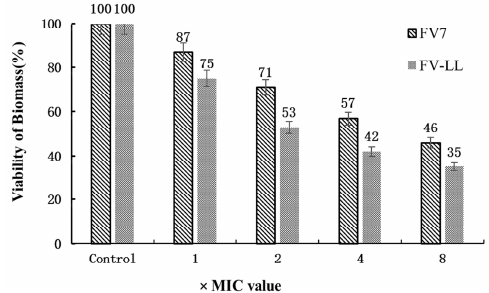
Figure 8. Anti-biofilm activity of the peptides. The viability of P. aeruginosa PAO1 biofilm was reduced after 24-h treatment at higher concentrations of FV7 and FV-LL. The test was performed at least four times in